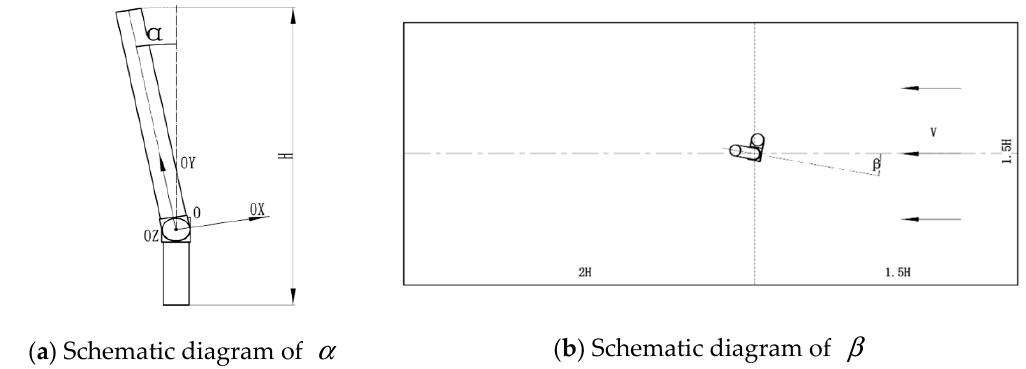
β . Figure 3. Schematic diagram of the calculation domain and α / β